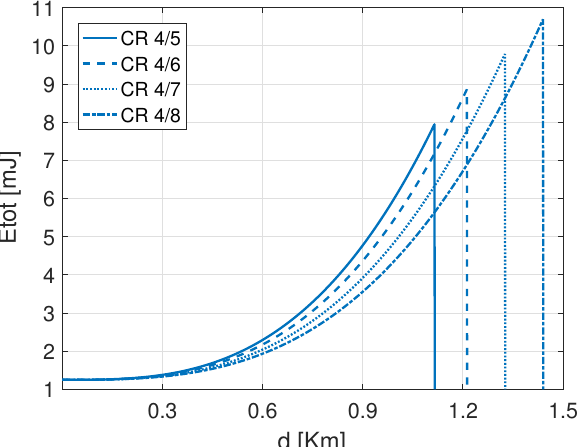
Figure 5. Total consumed energy at different ranges d using different CRs with SF 7 to carry out a 30 Bytes